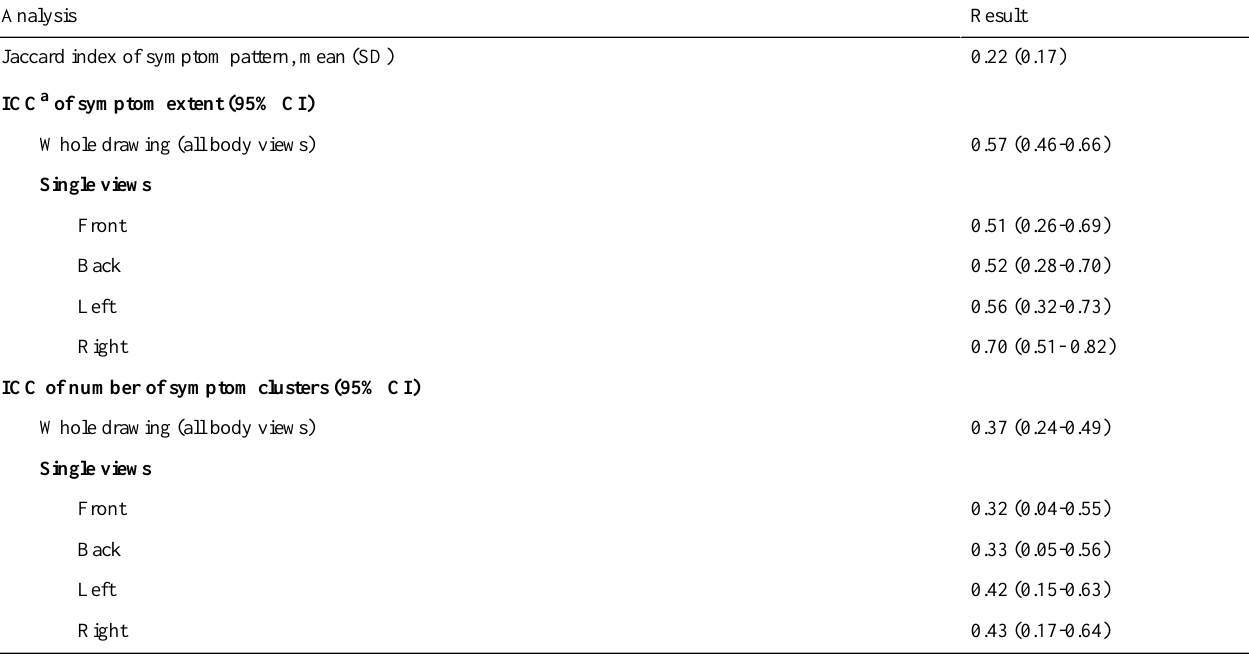
Table 3. Similarity of doctors’and patients’pain drawings.